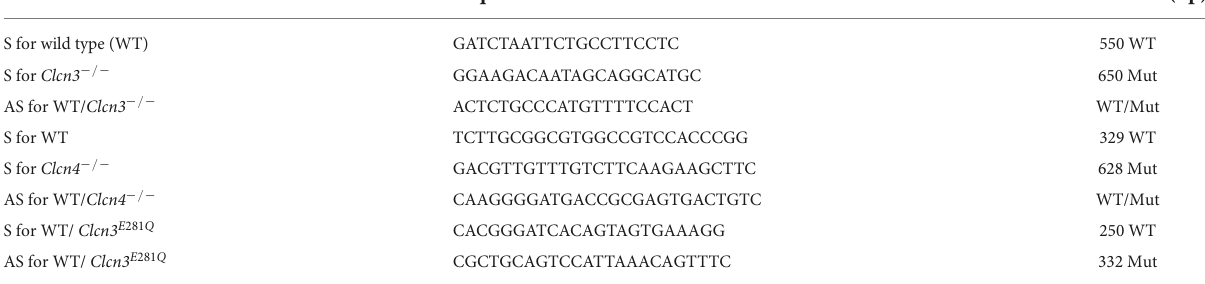
TABLE 1 List of primers used for